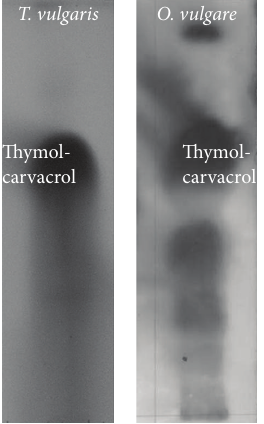
Figure 1: Thin layer chromatography of T. vulgaris and O. vulgare essential oils. Table 2: Physicochemical properties of the essential oils: yield